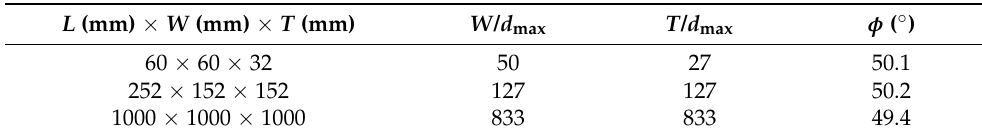
Table 3. Friction angles of a sand with d max = 1.2 mm, obtained by direct shear tests with three shear box sizes [28].